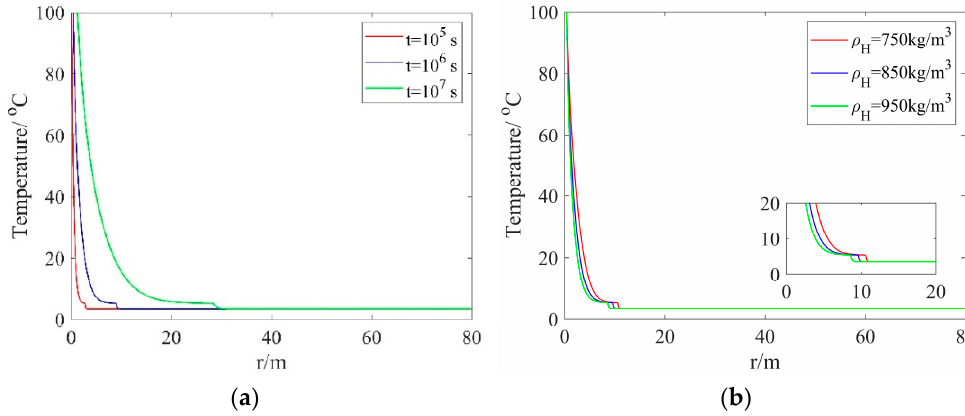
Figure 3. Temperature distribution along the radial direction: ( a ) different injection times and a fixed hydrate density; ( b ) different hydrate densities and a fixed injection time. hydrate density; ( b ) different hydrate densities and a fixed injection